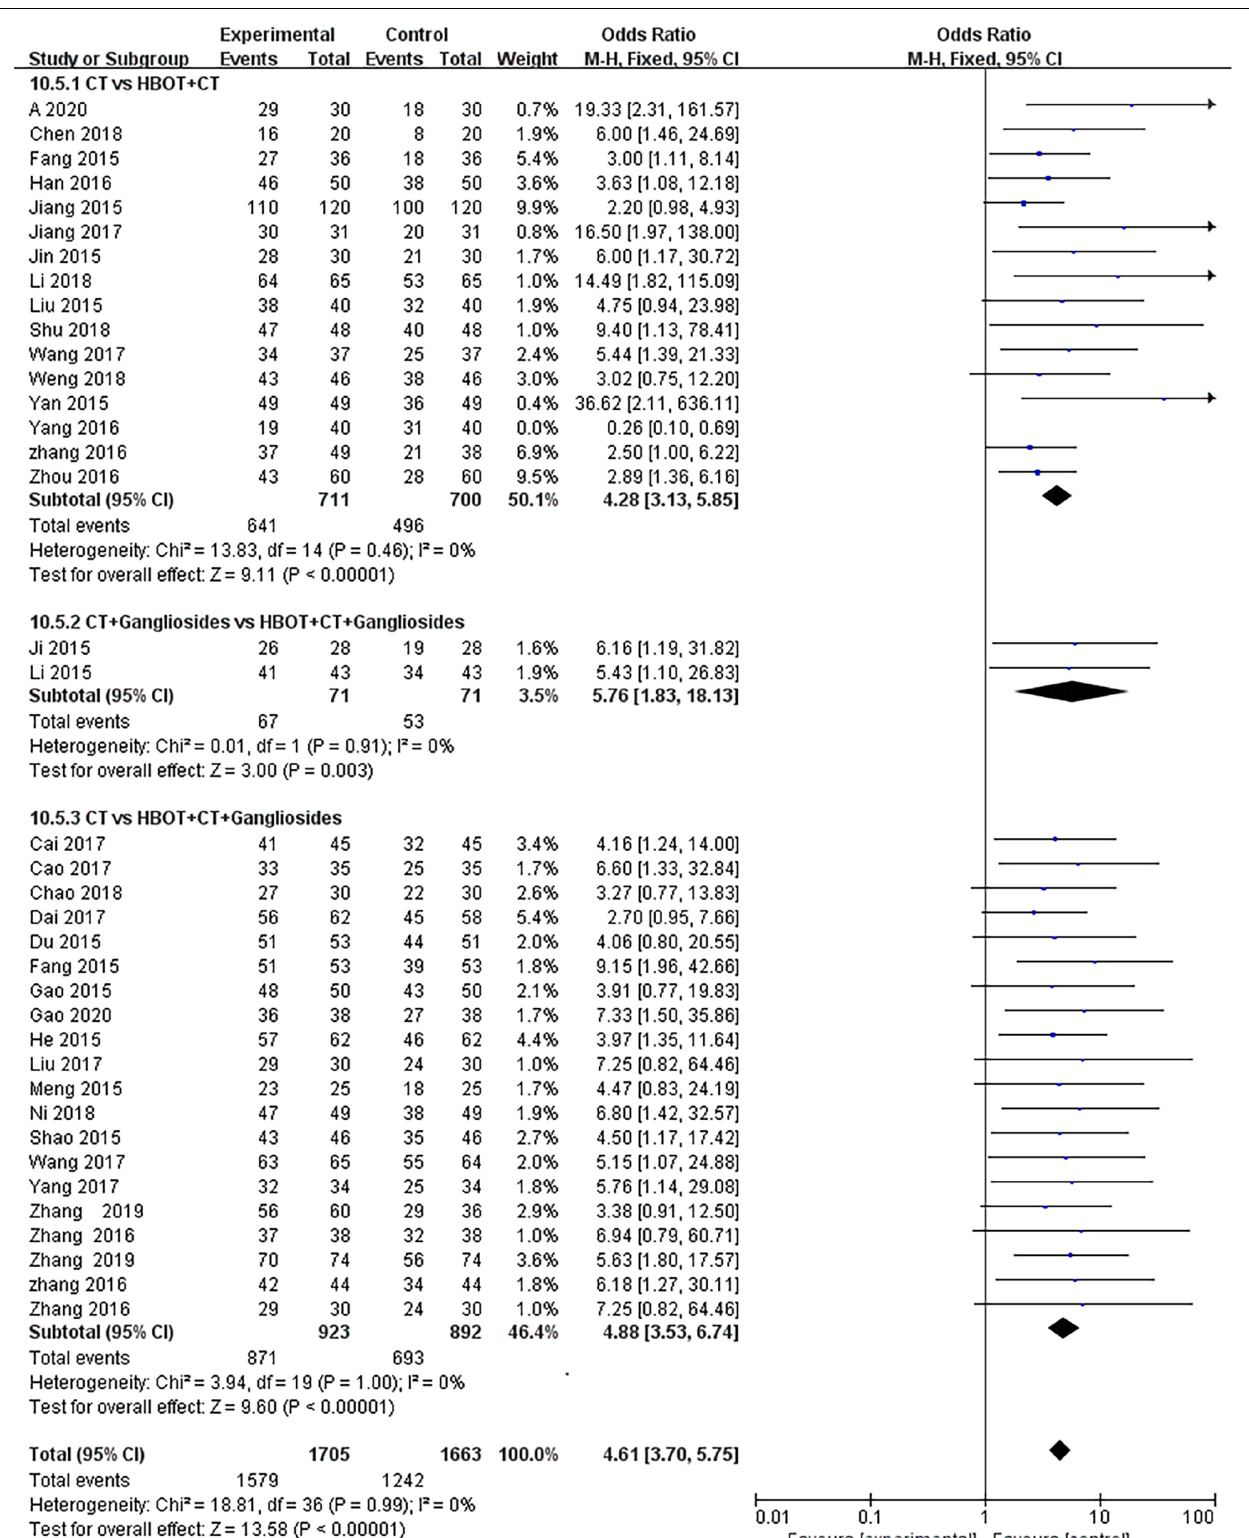
FIGURE 4 | Subgroup analysis of TEF: (1) CT vs. HBOT + CT; (2) CT + Gangliosides vs. HBOT + CT + Gangliosides; (3) CT vs. HBOT + CT + Gangliosides.